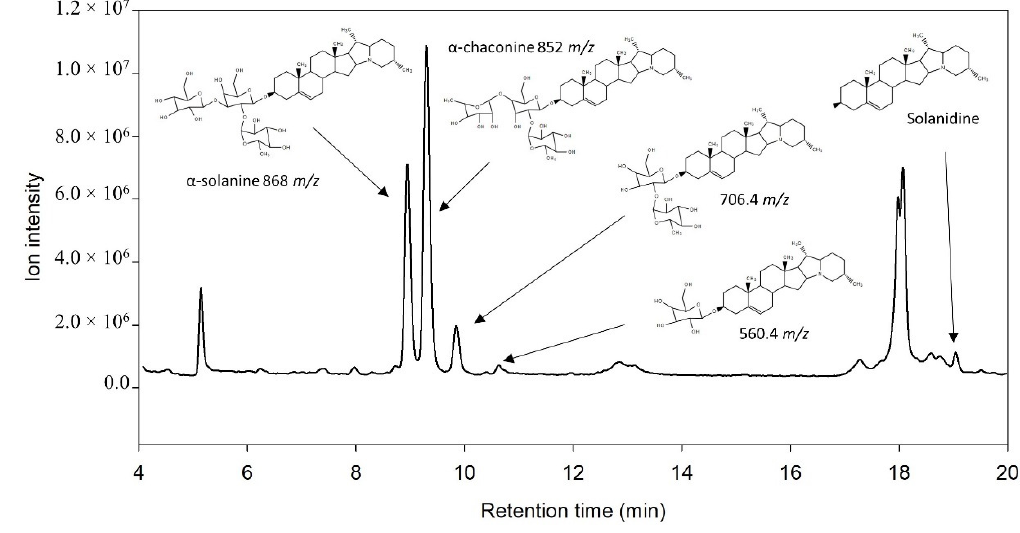
Figure 5. LC–ESI/MS chromatogram of feed-grade potato protein power and the different forms of glycoalkaloids identified.